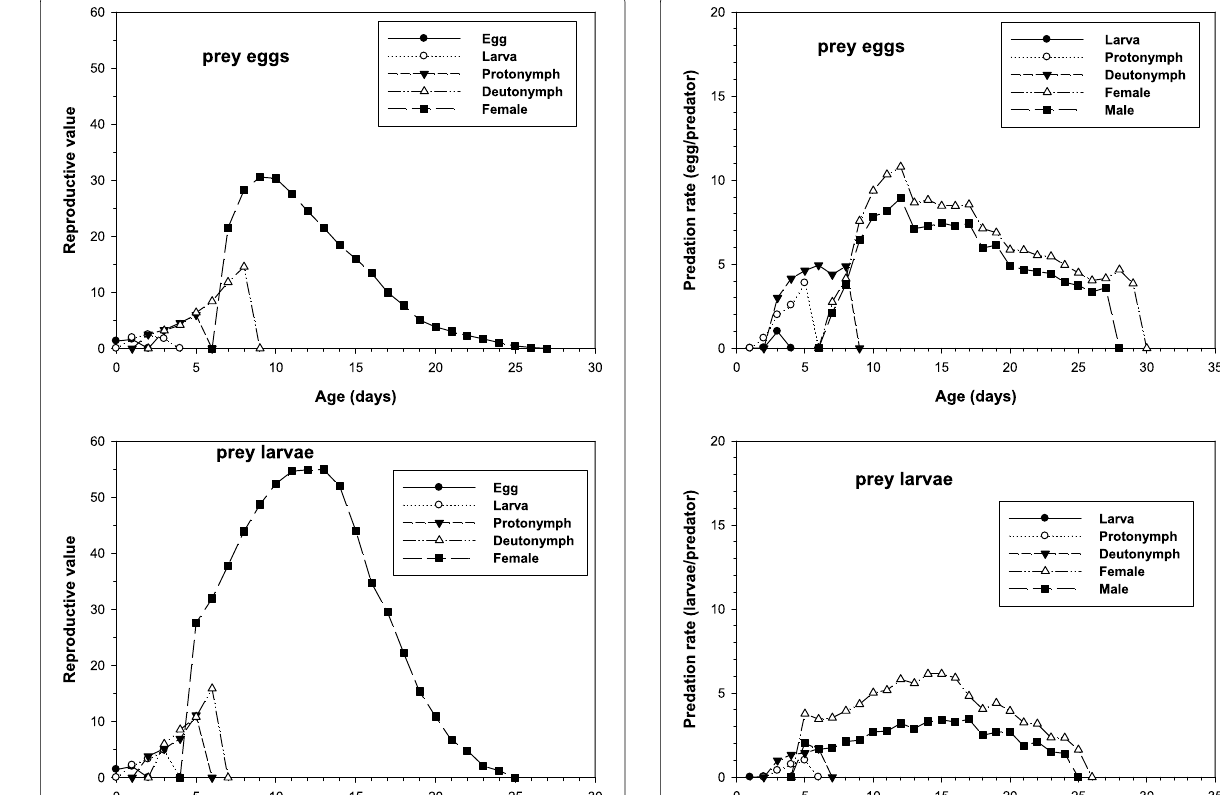
Table 3 Life table parameters of Blattisocius mali fed on eggs and larvae of Tyrophagus putrescentiae Parameters